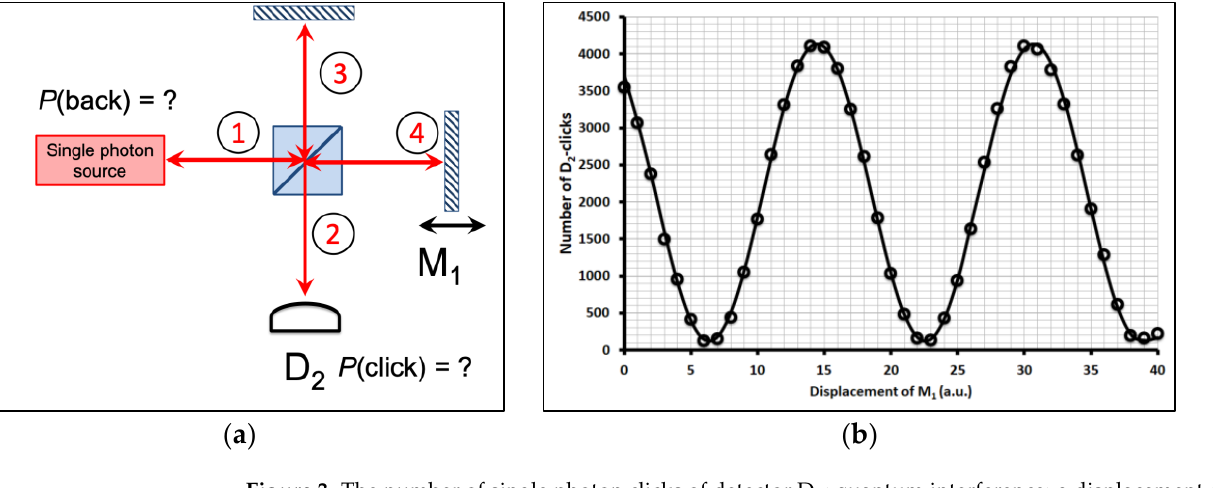
Figure 3. The number of single photon clicks of detector D 2 ; quantum interference: a displacement of the mirror M 1 produces a periodic variation of the counting rate even in the case of single photon states; visibility V = 93%; ( a ) the setup and ( b ) experimental results.